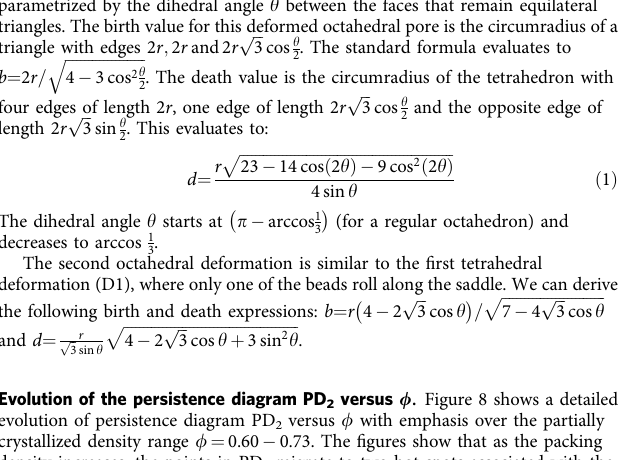
Evolution of the persistence diagram PD 2 versus / . Figure 8 shows a detailed evolution of persistence diagram PD 2 versus f with emphasis over the partially crystallized density range f ¼ 0.60 (cid:2) 0.73. The figures show that as the packing density increases, the points in PD 2 migrate to two hot spots assosiated with the location of the tetrahedral and octahedral